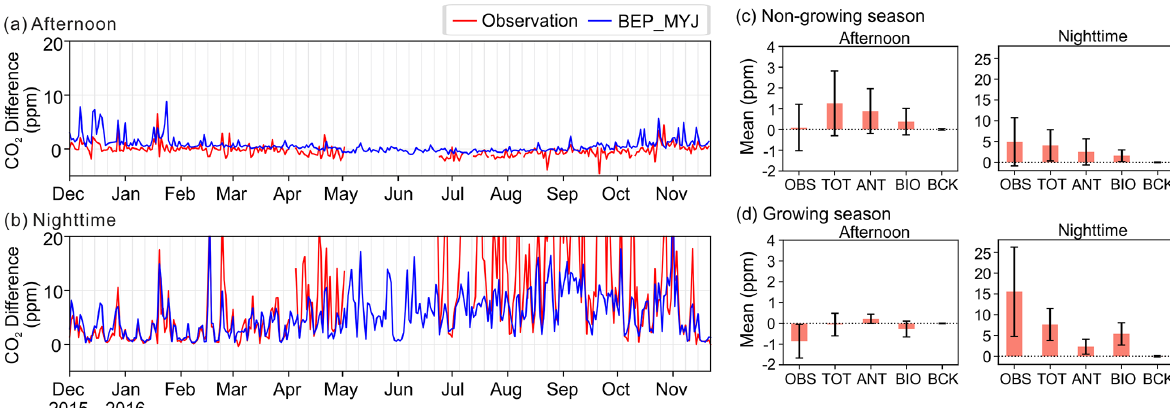
Figure 10. Daily (a) afternoon mean (11:00–16:00UTC) and (b) nighttime mean (21:00–05:00UTC) CO 2 vertical differences at SAC (15– 100m). Daily CO 2 vertical differences at SAC (15–100m) from each sector for (c) the non-growing season from October to April and (d) the growing season from May to September. OBS indicates the observed CO 2 concentration differences. TOT, ANT, BIO, and BCK indicates the simulated total, anthropogenic, biogenic, and background CO 2 concentration differences